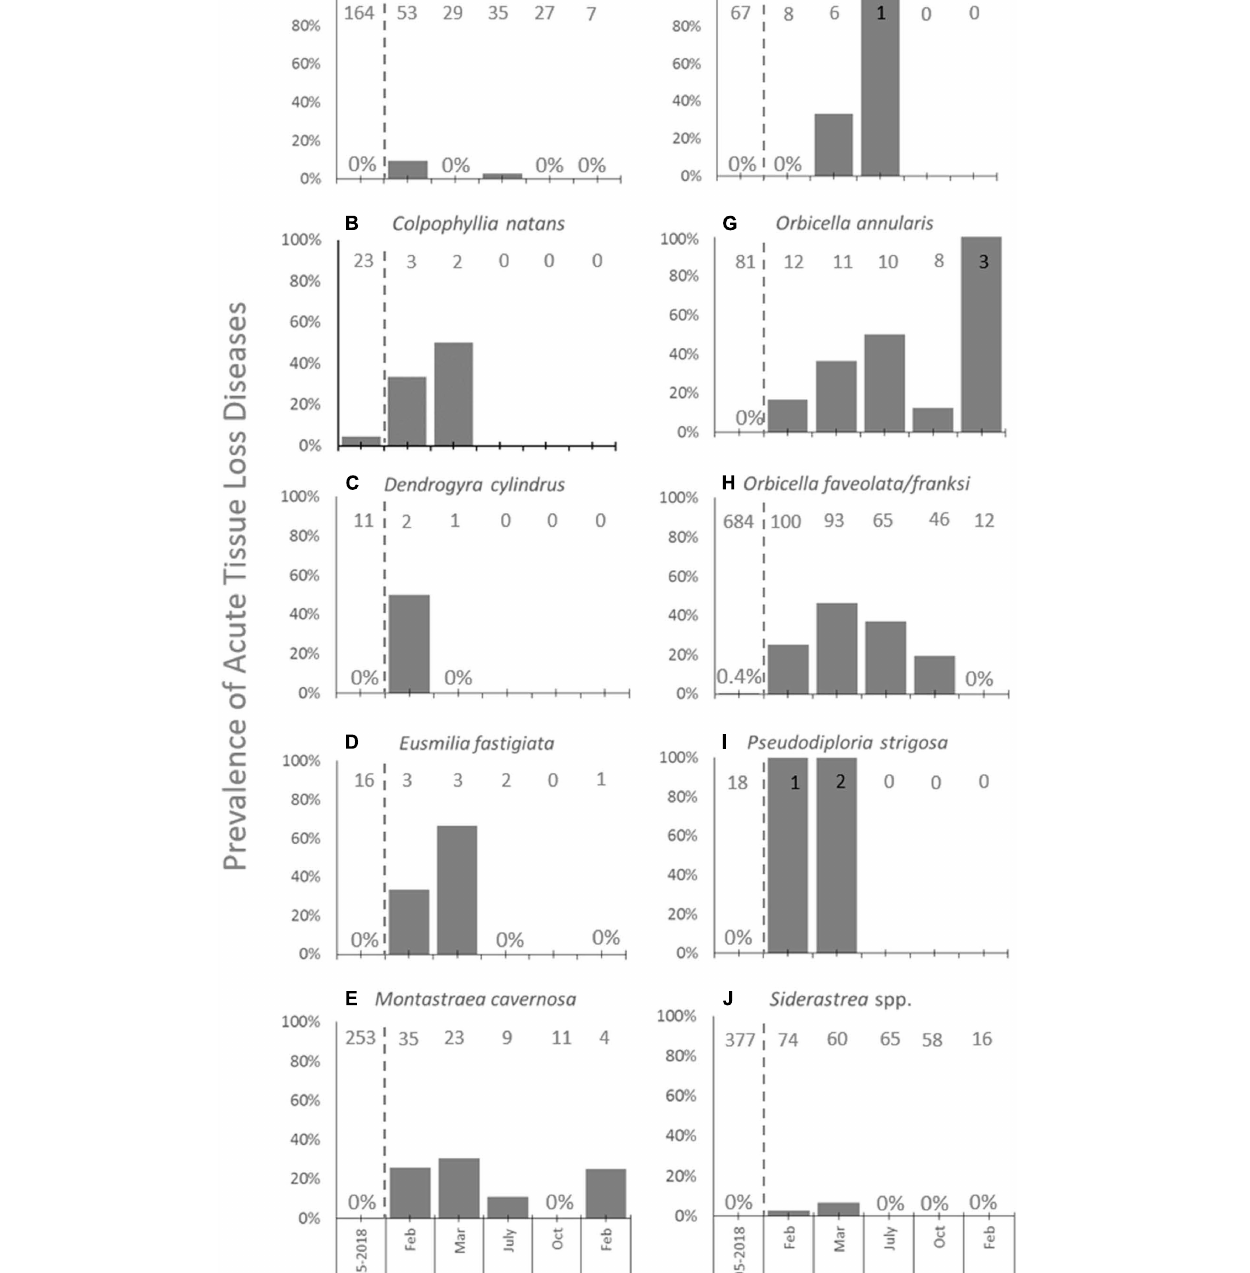
March 2019, likely because individuals of these species died from disease and no longer appeared in the transects, save for one E. fastigiata . M. meandrites , a highly susceptible species and often